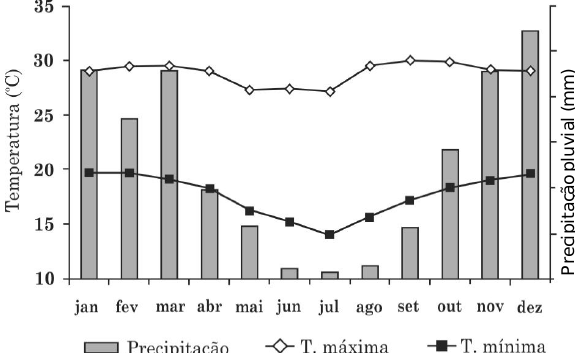
Figura 1. Temperatura média mensal (máxima e mínima) (°C) e precipitação pluvial média (mm) no bioma Cerrado, em Rio Verde (GO). Os dados são referentes ao período de 1972 a 2004. Fonte: Cooperativa Mista dos Produtores Rurais do Sudoeste Goiano Ltda